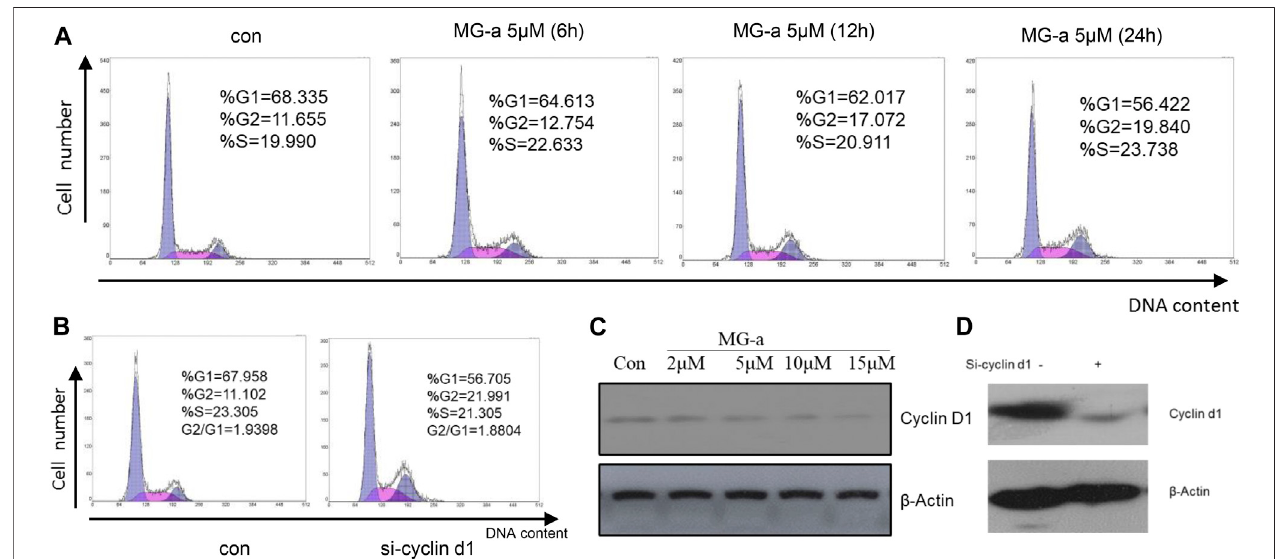
FIGURE 5 | The effect of α -Mangostin on the MDA-MB-231 cell cycle depends on cyclin D1. (A) The sub-G1 ratio in MDA-MB-231 cells treated with MG-a was examinedby fl owcytometry.Cellswereexposedto5 μ M MG-aattheindicatedtimes,after whichcellswereharvested and stainedwithPI.FACSwasused tomeasure the sub-G1 percentage. (B) The sub-G1 ratio in MDA-MB-231 cells treated with siCCND1 wasexamined using fl owcytometry. (C,D) The expression levels of cyclin D1 were determined by western blotting analysis in MDA-MB-231 cells after α -Mangostin treatment (C) and knockdown of RXR α (D)